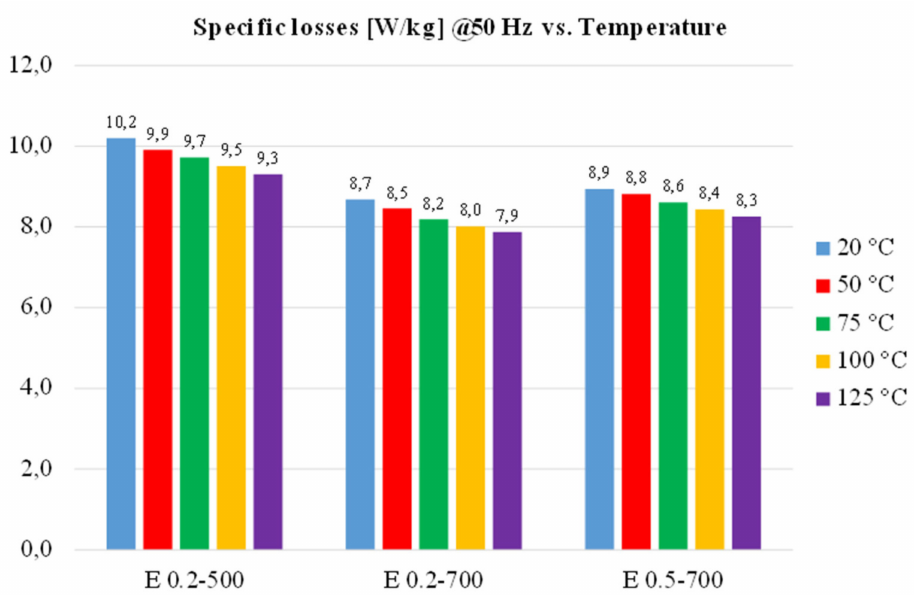
Figure 14. Specific iron losses @1T and 50 Hz at different temperatures of SMC samples.